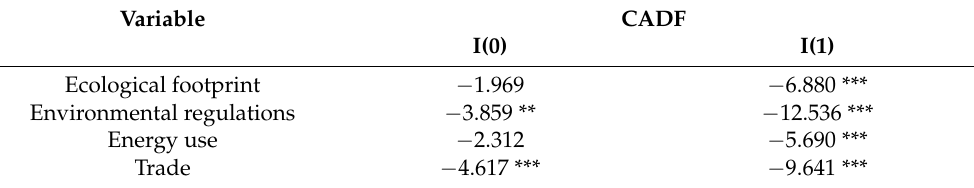
Table 4. Panel unit root test results. Variables are in logarithmic terms.